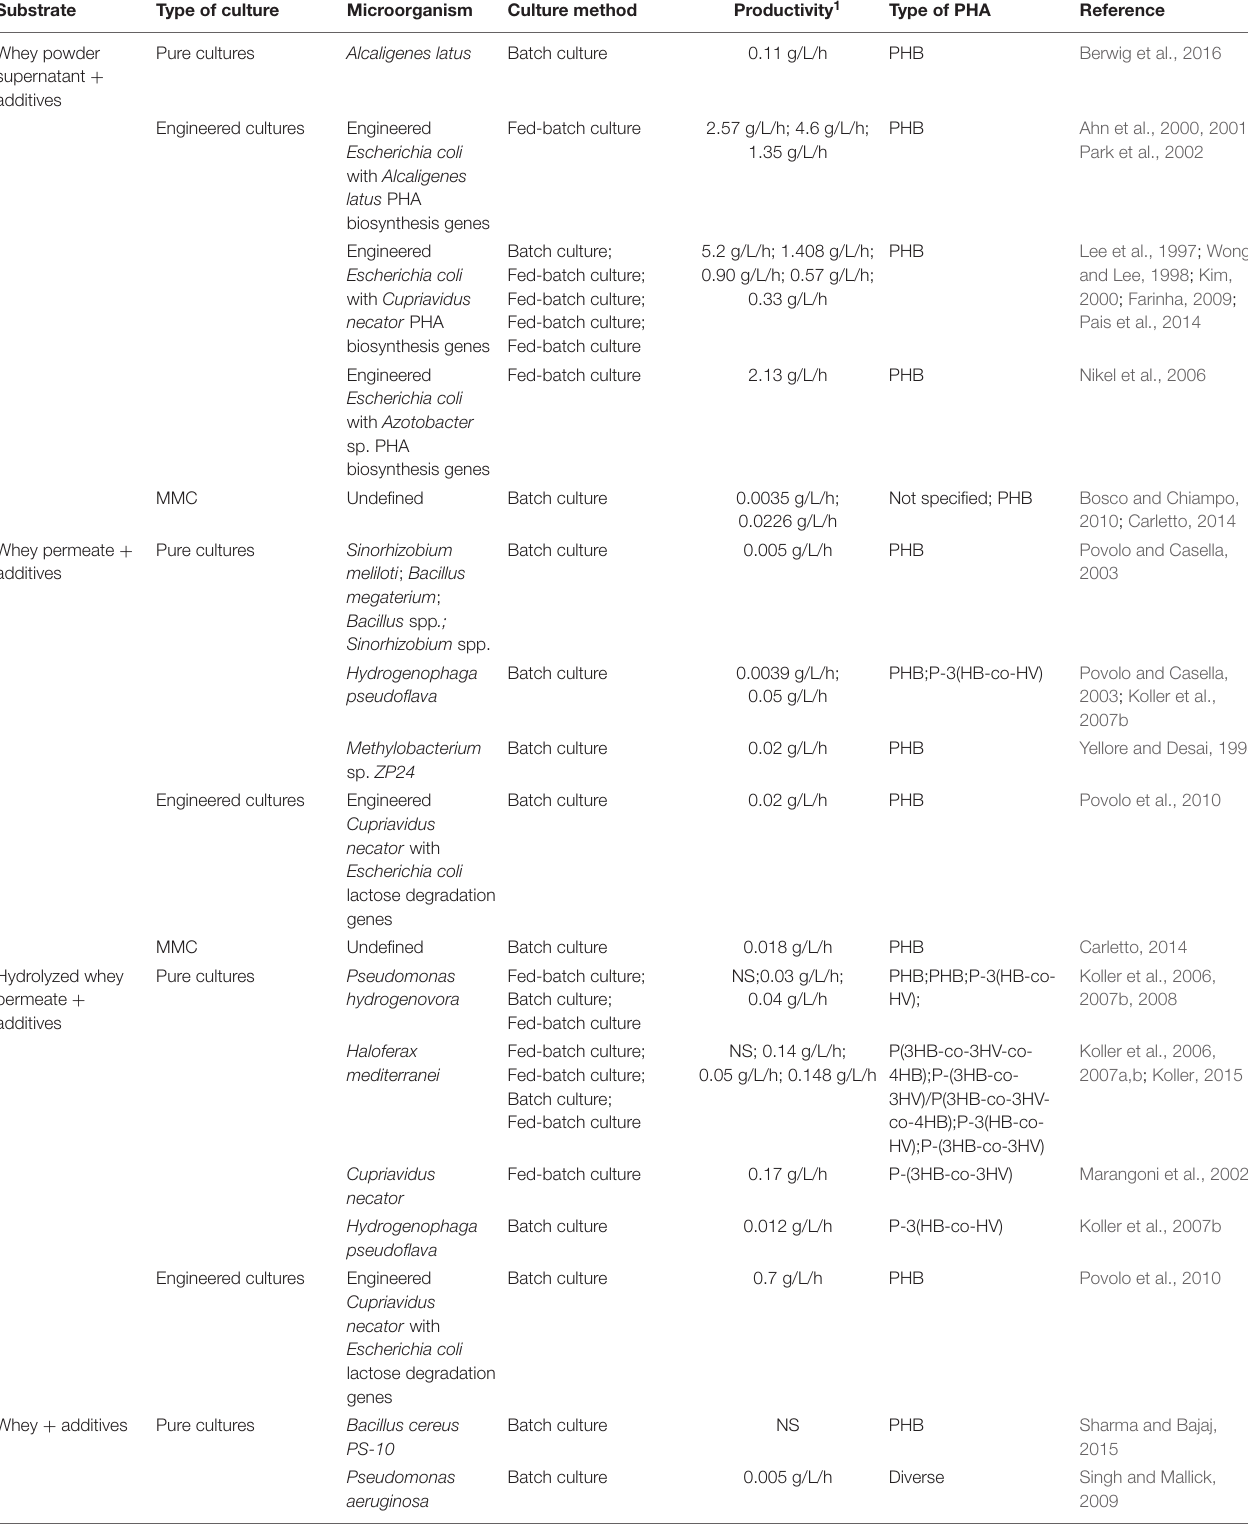
TABLE 1 | Summary of the studies aimed at producing PHAs from whey divided by the whey pre-treatment type.